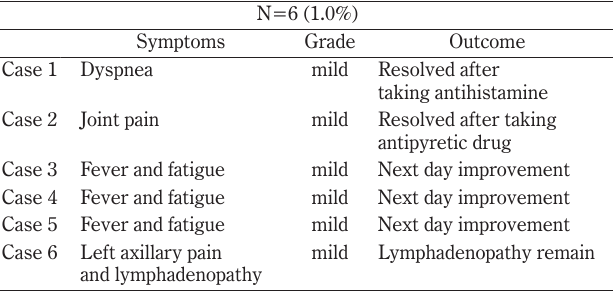
Table 2 Self-reported symptoms of adverse reaction to first dose of mRNA COVID-19 vaccines N=6 (1.0%)